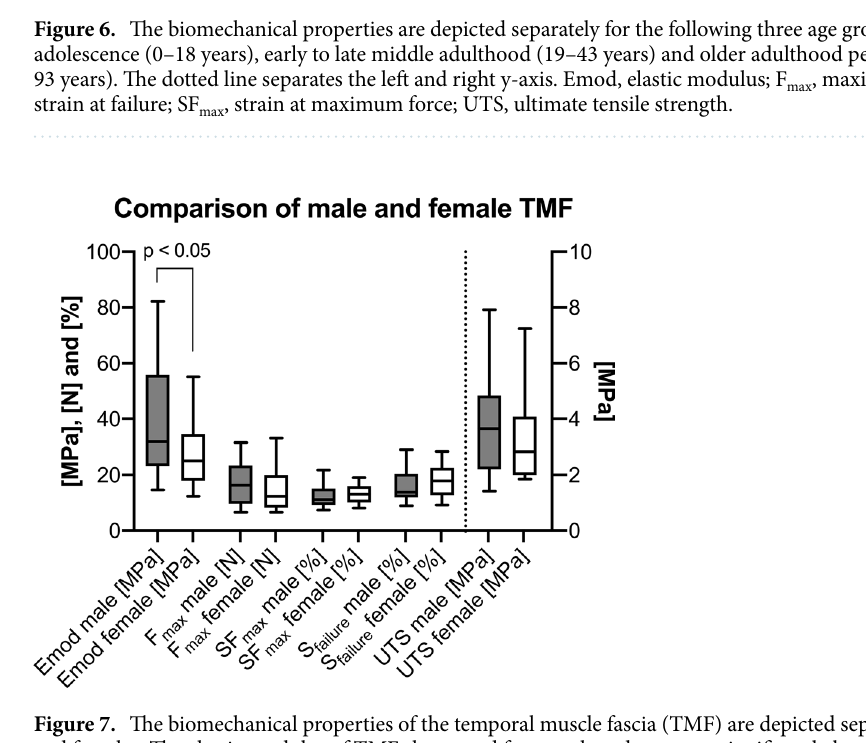
Figure 7. The biomechanical properties of the temporal muscle fascia (TMF) are depicted separately for males and females. The elastic modulus of TMFs harvested from male cadavers was significantly larger compared to female ones. The outlines of the boxes indicate the 25% and 75% percentile, the solid black line within the boxes represents the median. Whiskers indicate the minimum and maximum. The dotted line separates left and right y-axis. Emod, elastic modulus; F max , maximum force; SF max , strain at maximum force; S failure , strain at failure; UTS, ultimate tensile